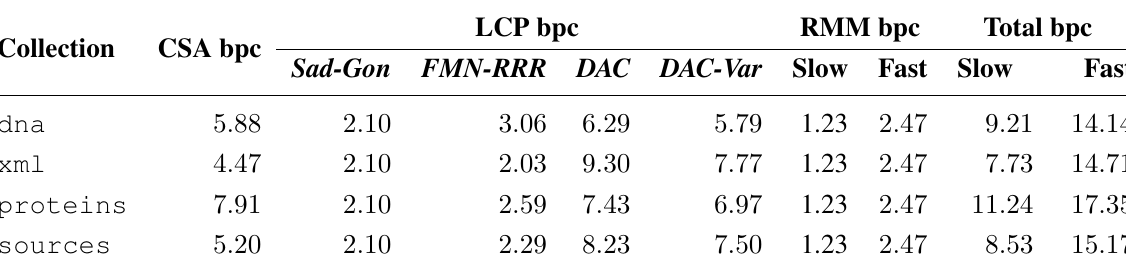
Table 3. Space breakdown of our compressed suffix